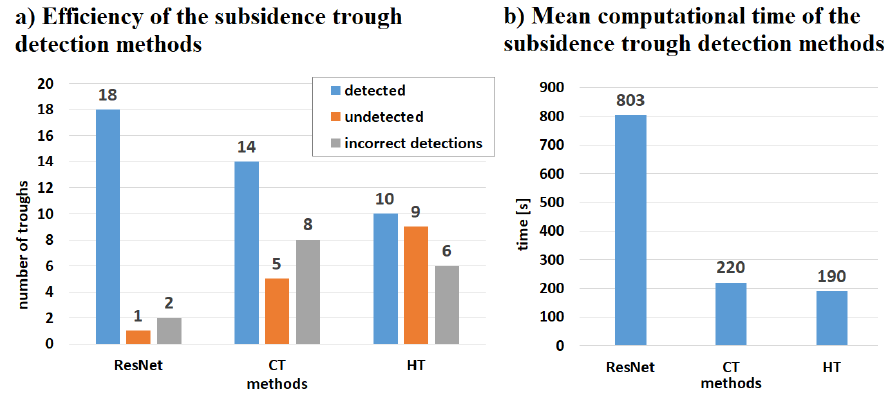
Figure 16. Efficiency ( a ) and computational time ( b ) measured for the tested interferograms (Figures 8 and 9). The computational time of the ResNet-50 network image classification was mea- sured only for the classification